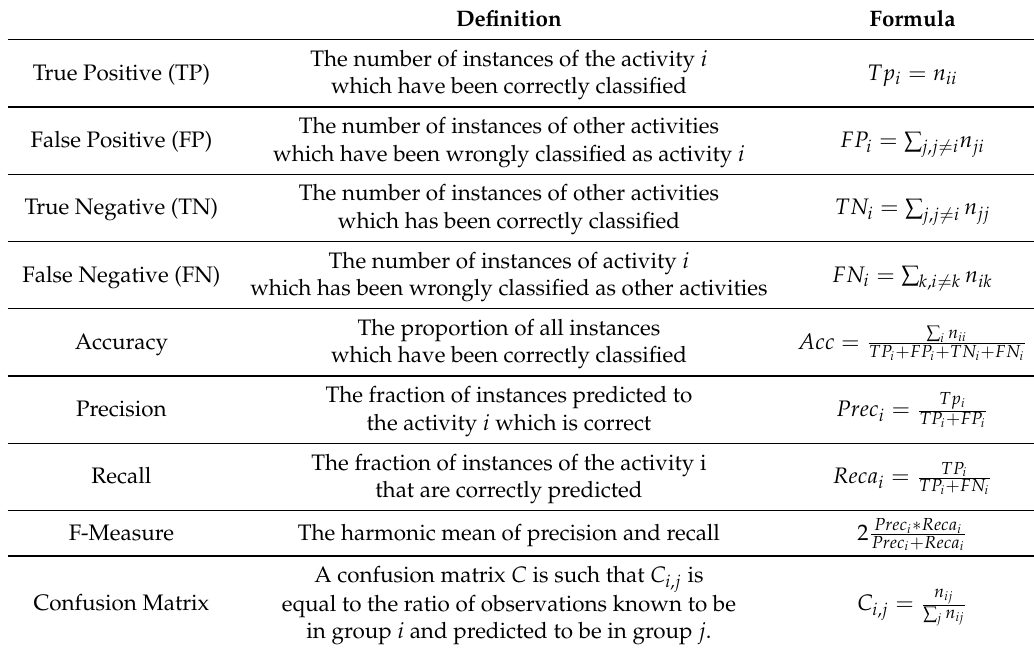
Table 5. Performance